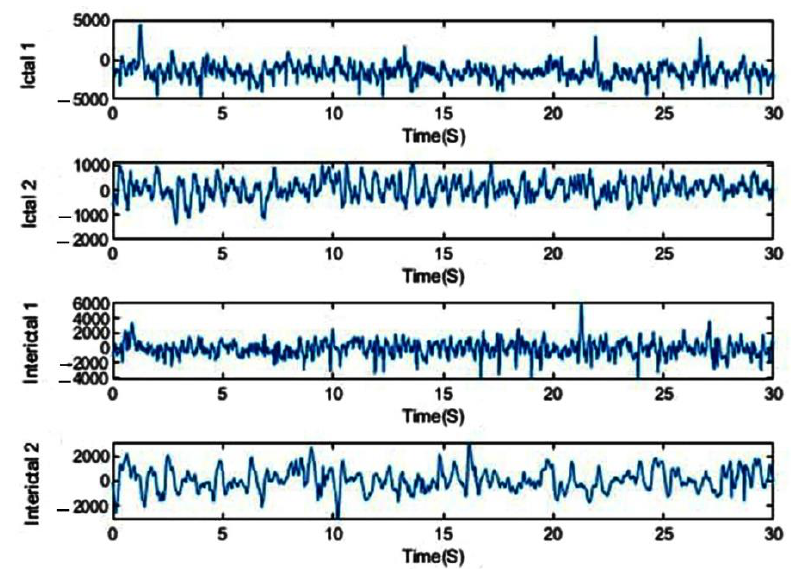
Table 4. Further details about the Freiburg dataset.